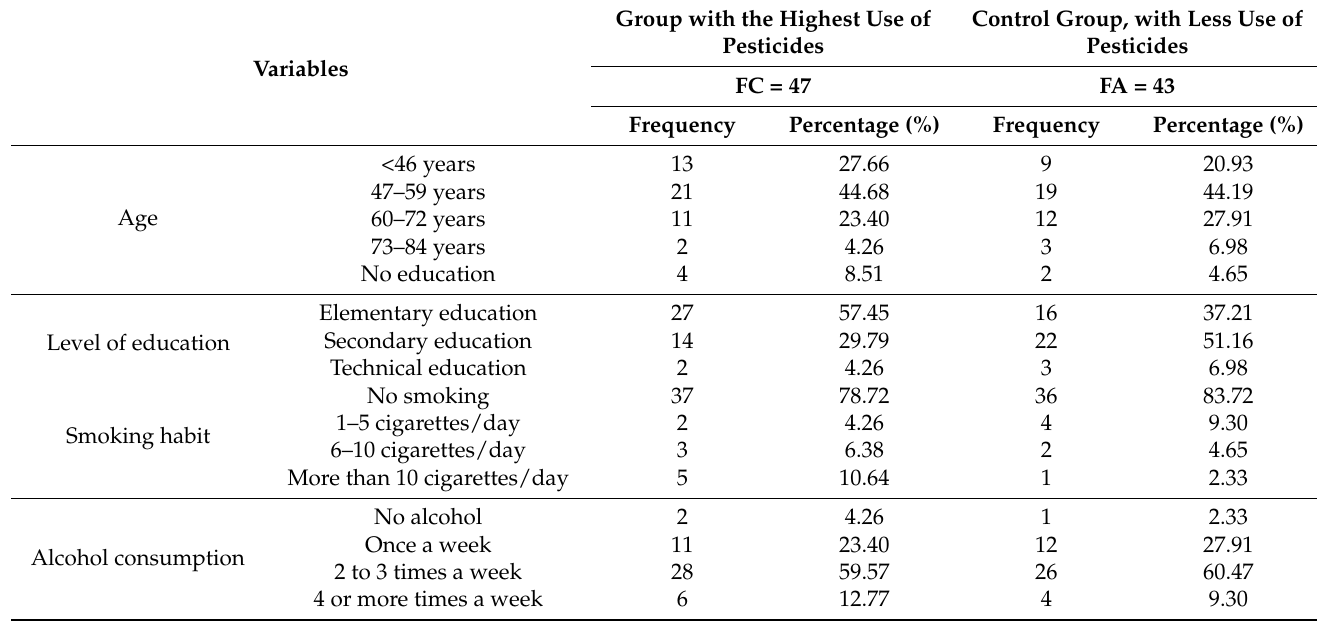
Table 1. Sociodemographic characteristics of the groups under